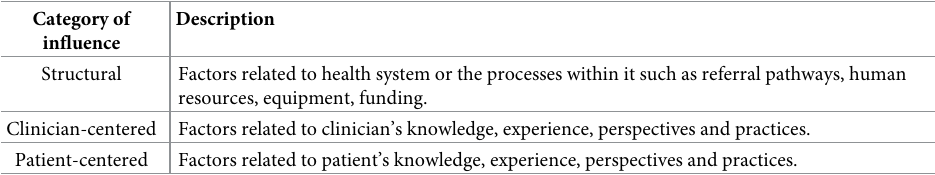
Table 1. Categories of influence within qualitative